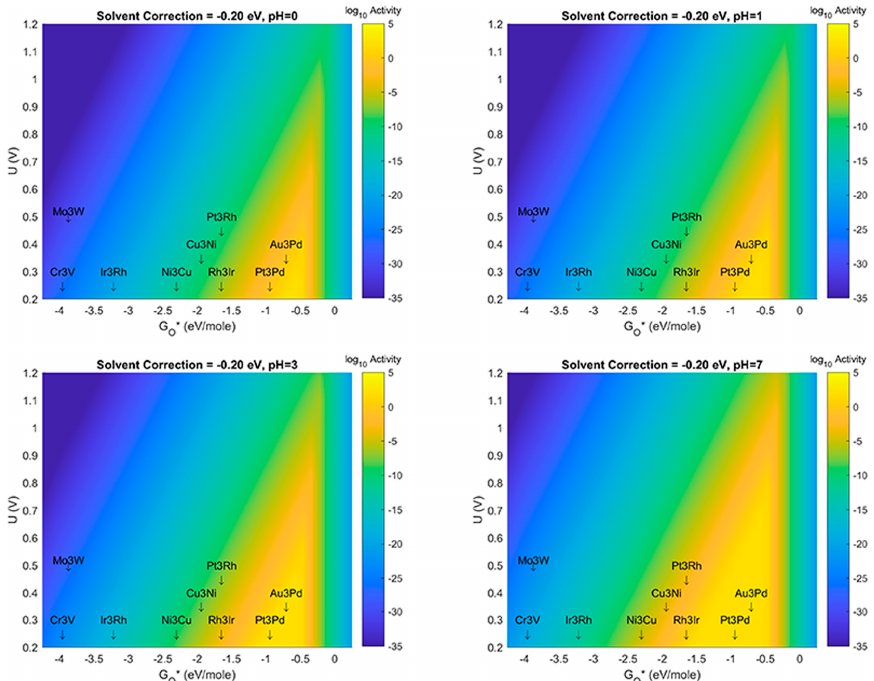
Figure 7. Volcano Plot analysis for ORR activity at solvent correction value of − 0.35 eV. Top left (pH = 0), Top right (pH = 1), Bottom left (pH = 3), Bottom Right (pH = 7). Blue denotes lowest activity, yellow denotes highest activity. All plots use same color-axis scale hence some saturation at maximum activity and minimum activity. Activity given in log10 scale to show more detail in plot.